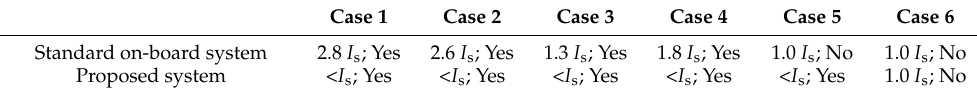
Table 3. Comparison of the standard on-board system with the proposed